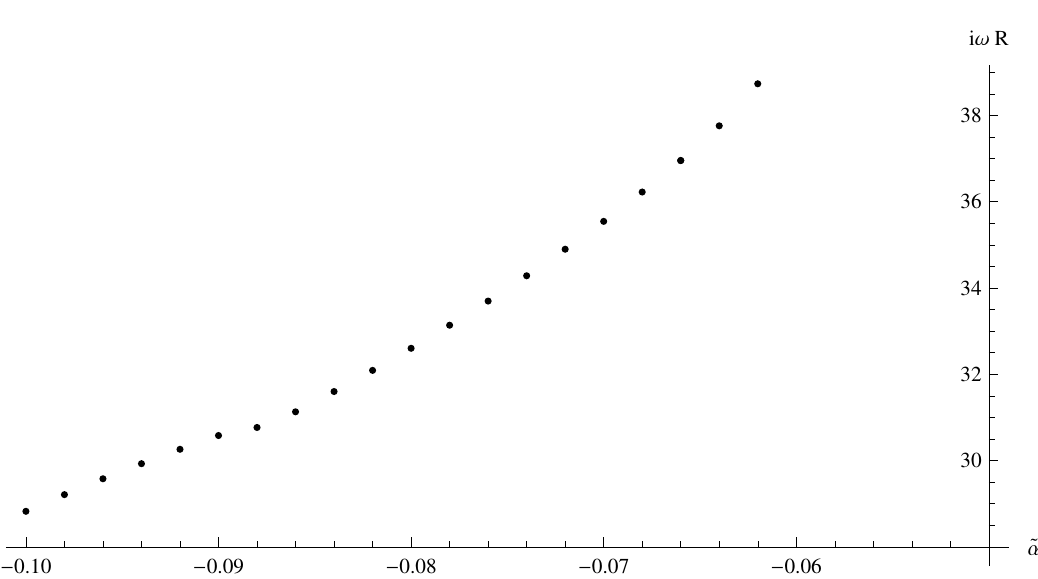
(cid:11) vector modes ( D = 5, r H =R = 6) as a function e